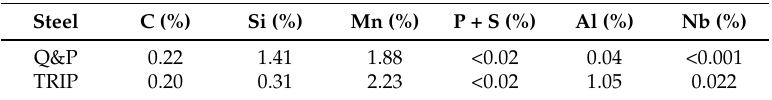
Table 1. Chemical composition (wt. %) of the Quenching and Partitioning (Q&P) and Transformation Induced Plasticity (TRIP) steels as measured by means of optical emission spectroscopy.